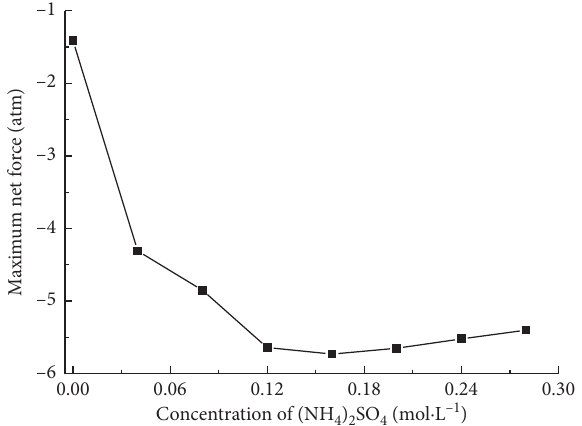
Figure 7: Relationship between net force and (NH